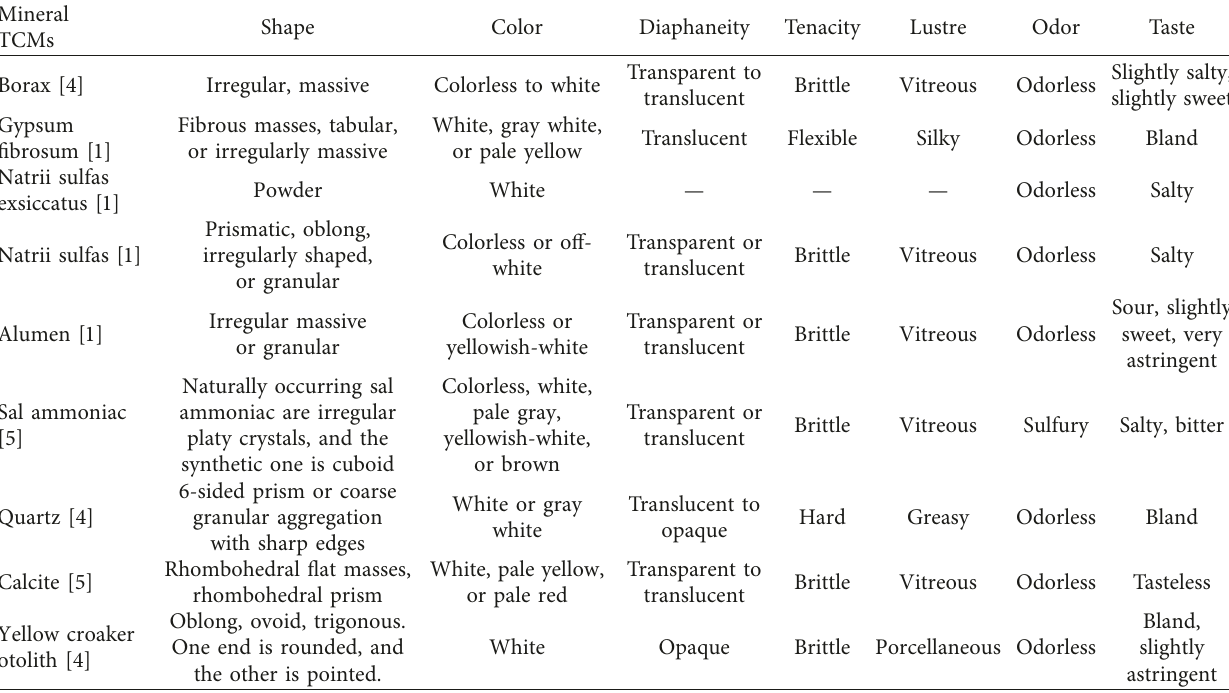
Table 1: Characteristics of nine mineral